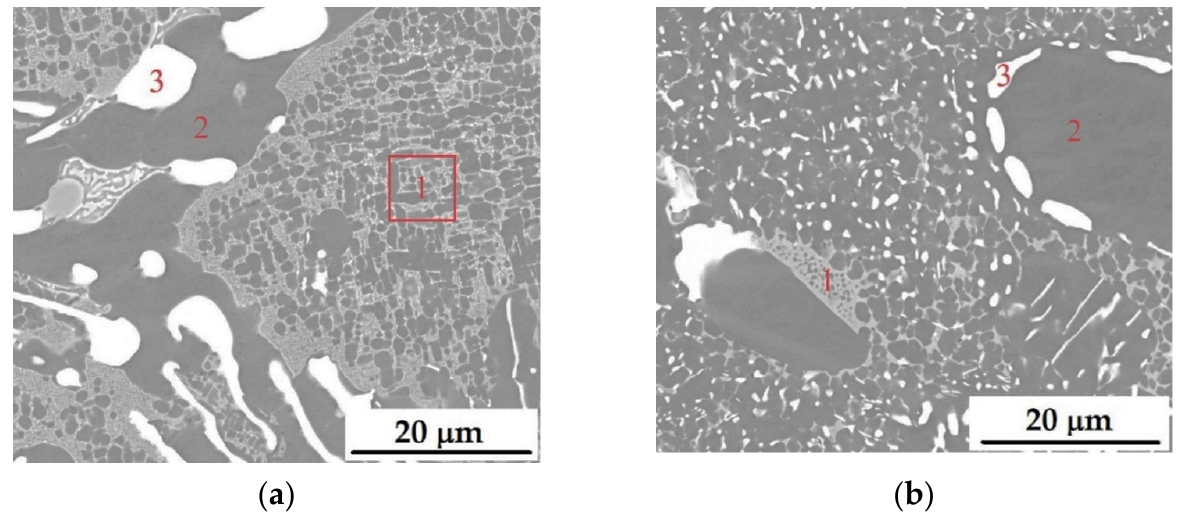
Figure 7. Microstructure of sample B: ( a ) Sample B50 after DS at rate 50 mm/h; ( b ) Sample B20 after DS at rate 20 mm/h; 1—two-phase regions γ / γ′ , 2— γ′ -Ni 3 (Al,Mo) phase, 3—Mo-rich phases.